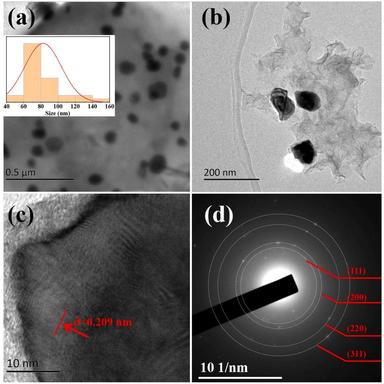
TEM (a and b), HRTEM (c) and SAED (d) images of Cu3Ni/NC nanocatalyst being stored in air for one year.